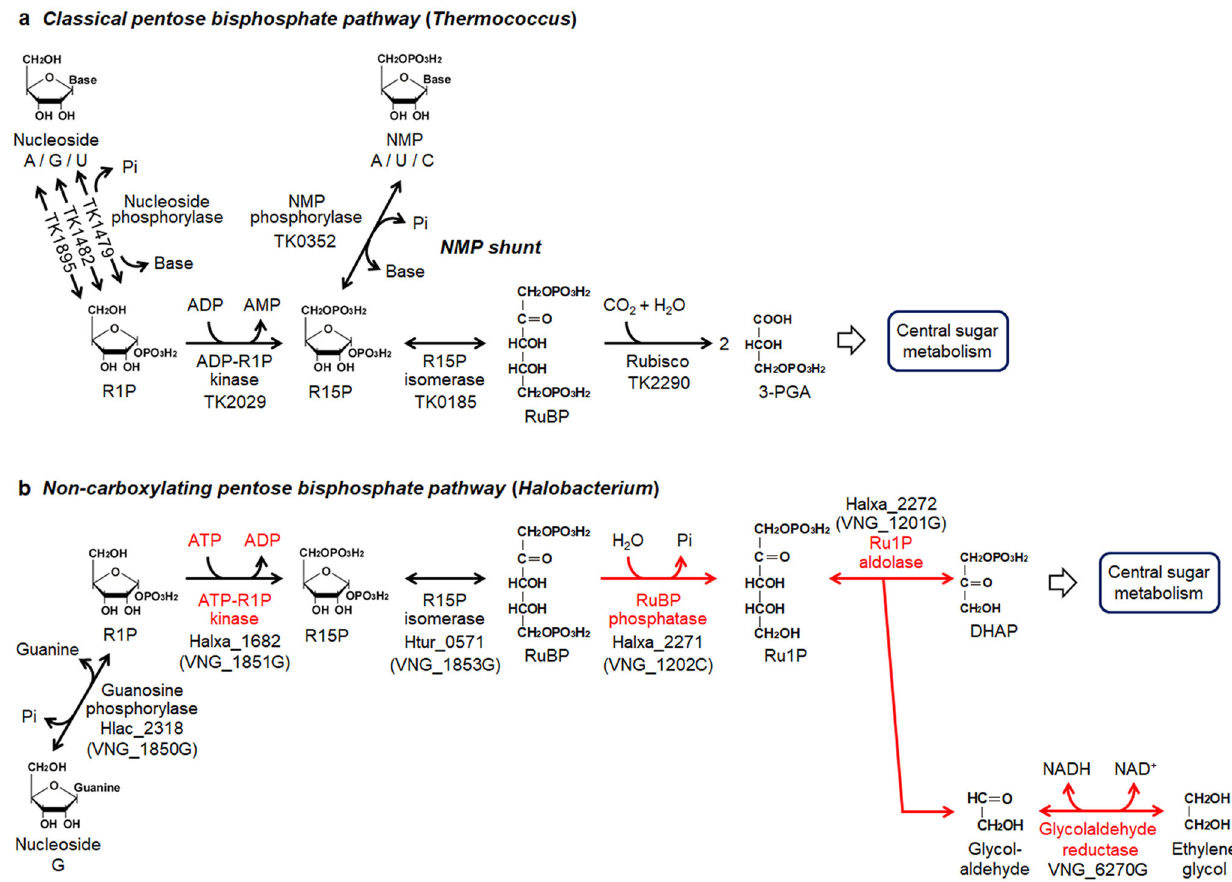
Fig. 1 Schematic drawing of archaeal nucleoside metabolic pathways in Thermococcus and in halophilic archaea including Halobacterium . a The classical pentose bisphosphate pathway identi fi ed in Thermococcus is predicted to be involved in the nucleoside degradation and/or the conversion of nucleosides to NMPs. The NMP shunt, composed of NMP phosphorylase, R15P isomerase, and Rubisco, degrades NMPs to 3-PGA. b The non-carboxylating pentose bisphosphate pathway proposed in this study is shown. Red arrows indicate reactions speci fi c to the pathway identi fi ed in this study and absent in the classical pentose bisphosphate pathway. The locus tags encoding the enzymes whose recombinant proteins were examined in this study are shown. Locus tags with parenthesis are genes predicted to encode enzymes whose activities were detected in the cell-free extract from H. salinarum . Regarding VNG_6270G, both native and recombinant enzymes were investigated. NMP nucleoside-5 ’ -monophosphate, R1P ribose-1-phosphate, R15P ribose-1,5- bisphosphate, RuBP ribulose-1,5-bisphosphate, 3-PGA 3-phosphoglycerate, Ru1P ribulose-1-phosphate, DHAP dihydroxyacetone